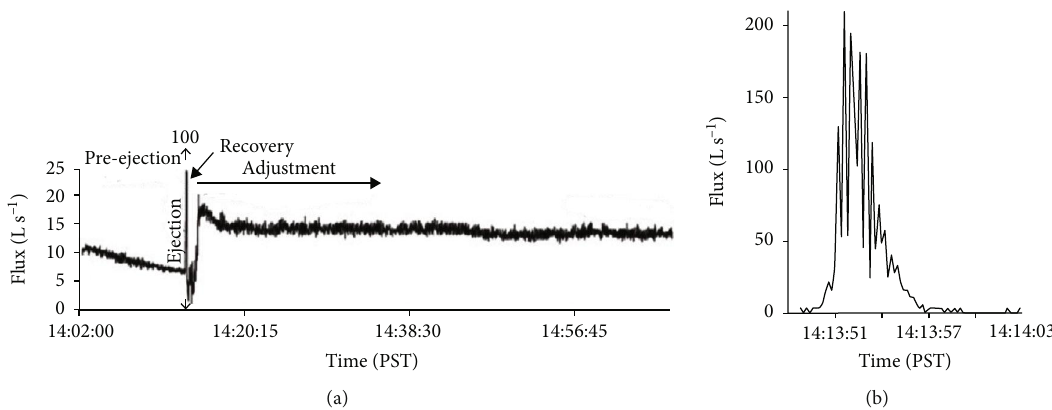
Figure 16: (a) Emission time series of a seep eruption at Shane Seep (20 m) in the Coal Oil Point seep fi eld. (b) Detailed time series of the eruption. Adapted from Leifer and Boles [114].